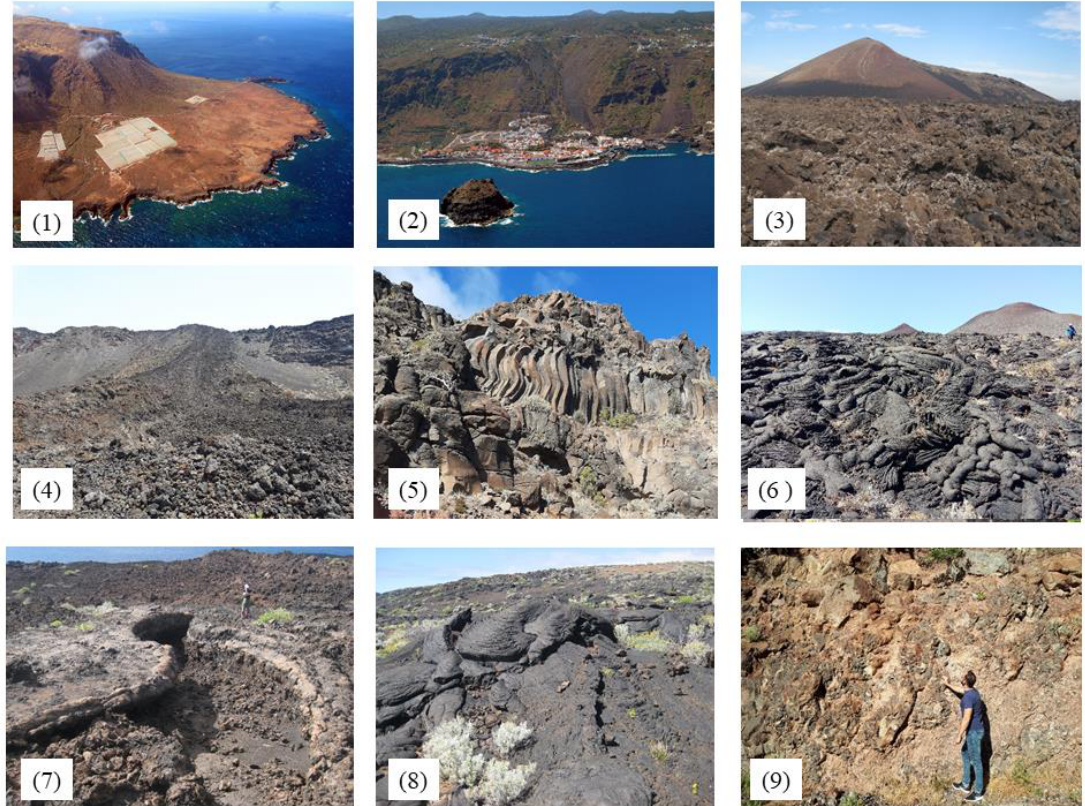
Figure 6. Morphologies associated with lava flows. Punta de Teno ( 1 ) and Garachico ( 2 ) lava deltas in Tenerife. Aa lava flows from Lanzarote ( 3 ). Teneguía aa cascade lava flows in La Palma ( 4 ). Columnar jointing in aa lava flows in La Gomera ( 5 ). Ropy surface and toes ( 6 ), lava channel ( 7 ) and pressure tumuli ( 8 ) in pahoehoe lava flows in El Hierro. Pillow lavas from Igueste de San Andrés in Tenerife ( 9 ). Source: photos 1 and 2 http://www.fotosaereasdecanarias.com.